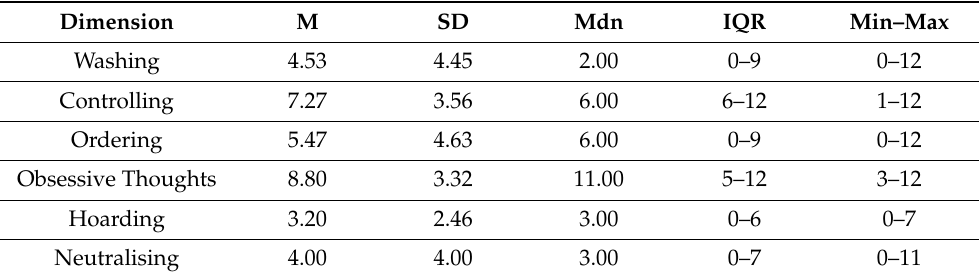
Table A11. Scores in the Obsessive Compulsive Inventory-Revised (OCI-R) of patients with OCD ( n = 15). Abbreviations: IQR, interquartile range; M, mean; Max, maximum; Mdn, median; Min, minimum; SD, standard deviation.